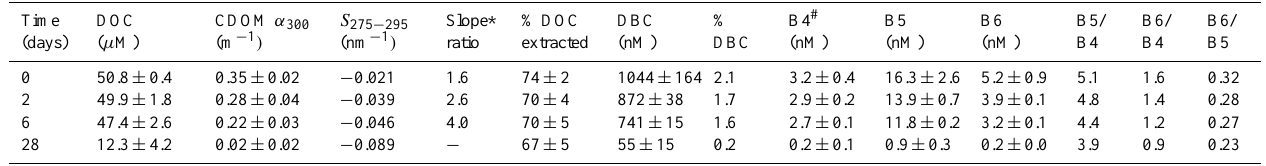
Table 1. Summary of results of North Atlantic Deep Water photodegradation over 28 days. Parameters included: dissolved organic carbon (DOC), coloured dissolved organic matter Naperian absorption coefficient at 300nm (CDOM α 300 ) , spectral slope in the range 275–295nm ( S 275 − 295 ) , the slope ratio ( S 275 − 295 : S 350 − 400 ) , percentage of total DOC extractable using PPL, the concentration of dissolved black carbon (DBC), DBC as a percentage of total DOC, and the concentrations and ratios of the individual DBC derived benzenepolycarboxylic